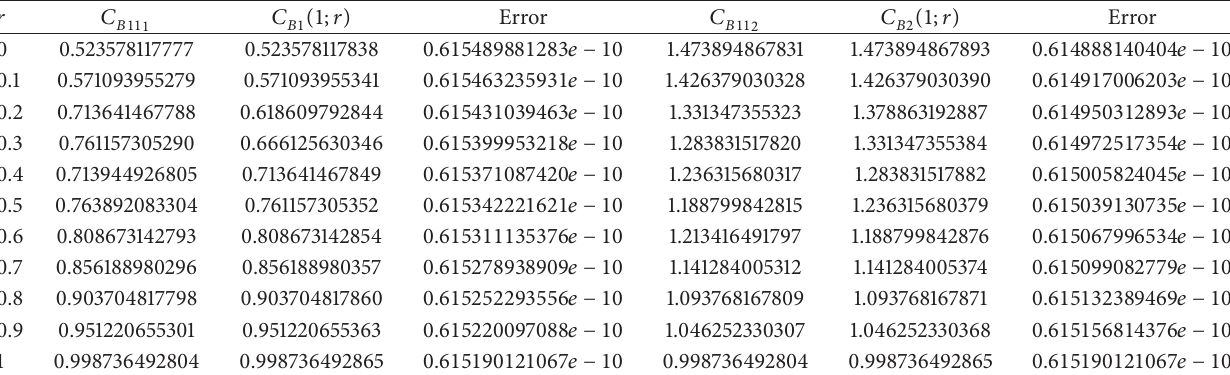
Table 4: The result of the proposed method for Example 27 with V = 𝛼 = 0.95 , 𝑚 = 11 , 𝑘 1 = 0.05 , and 𝑘 2 = 0.05